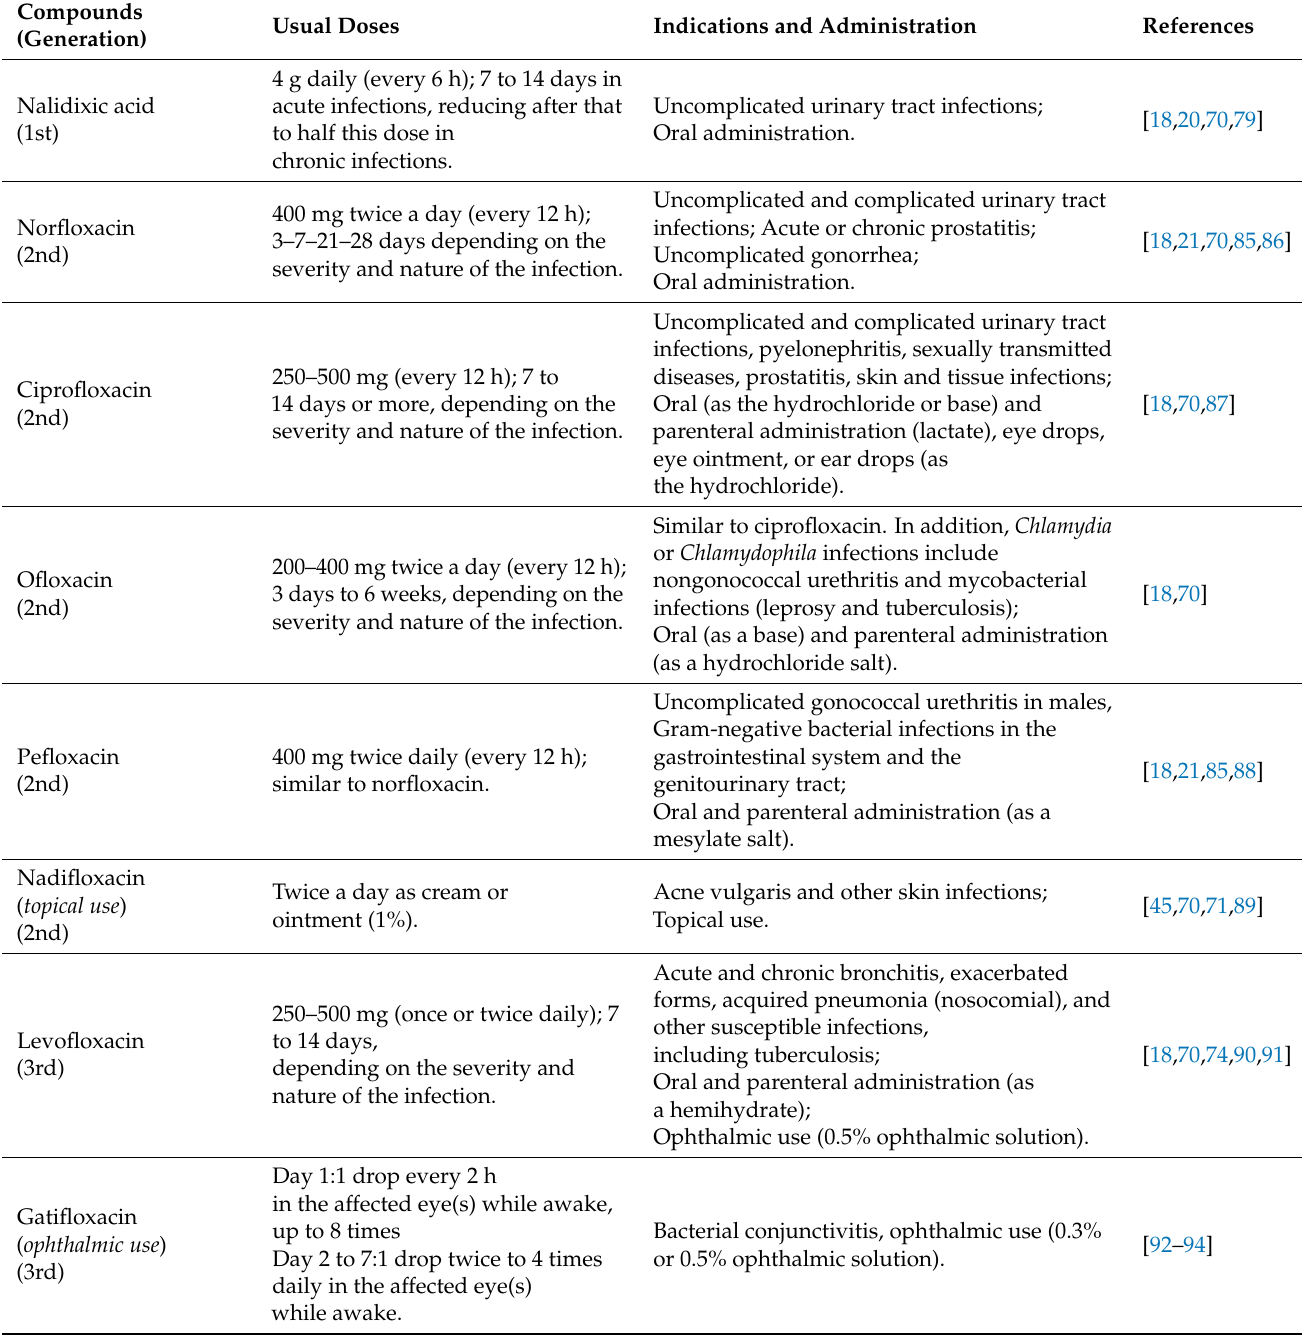
Table 2. Doses and therapeutic indications (US Food and Drug Administration (FDA) and European Medicines Agency (EMA)